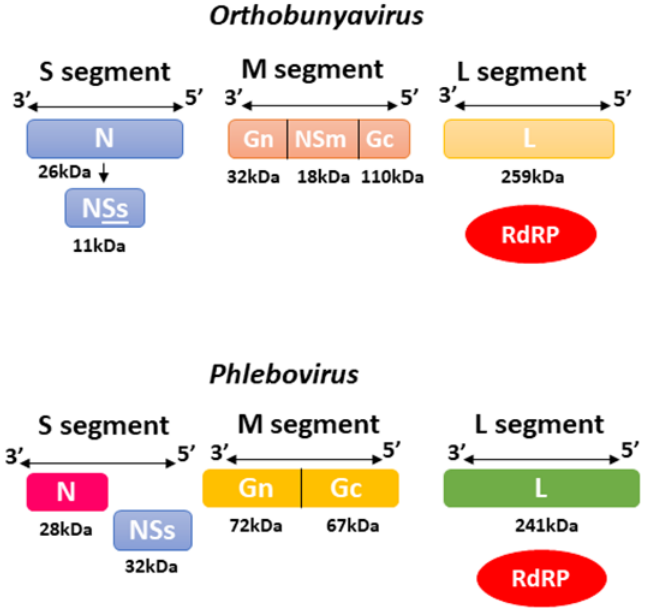
Figure 4. Genome segments of Orthobunyavirus and Phlebovirus . The three-segmented negative-sense single-strand RNA are nominated according to their size as L (large), M (medium) and S (small). The L segment encodes the multifunctional RNA-dependent RNA polymerase (RdRP) named L protein. The medium segment encodes the Gn and Gc glycoproteins, and the small segment encodes the nucleocapsid protein (N). Additional non-structural proteins such as NSm and NSs can also be encoded by segments M and S, respectively, which can be cleaved by cellular proteases during polyprotein maturation. Based on: Ferron et al. (2017)